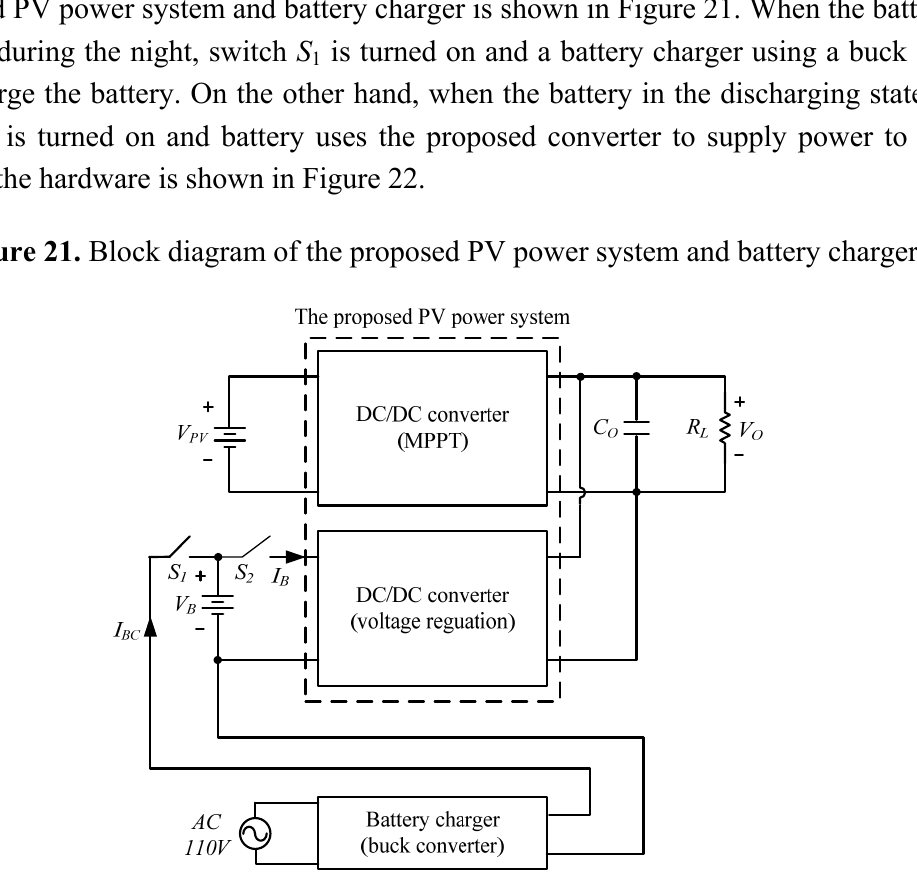
Figure 22. Photograph of the hardware for the proposed PV power system and battery